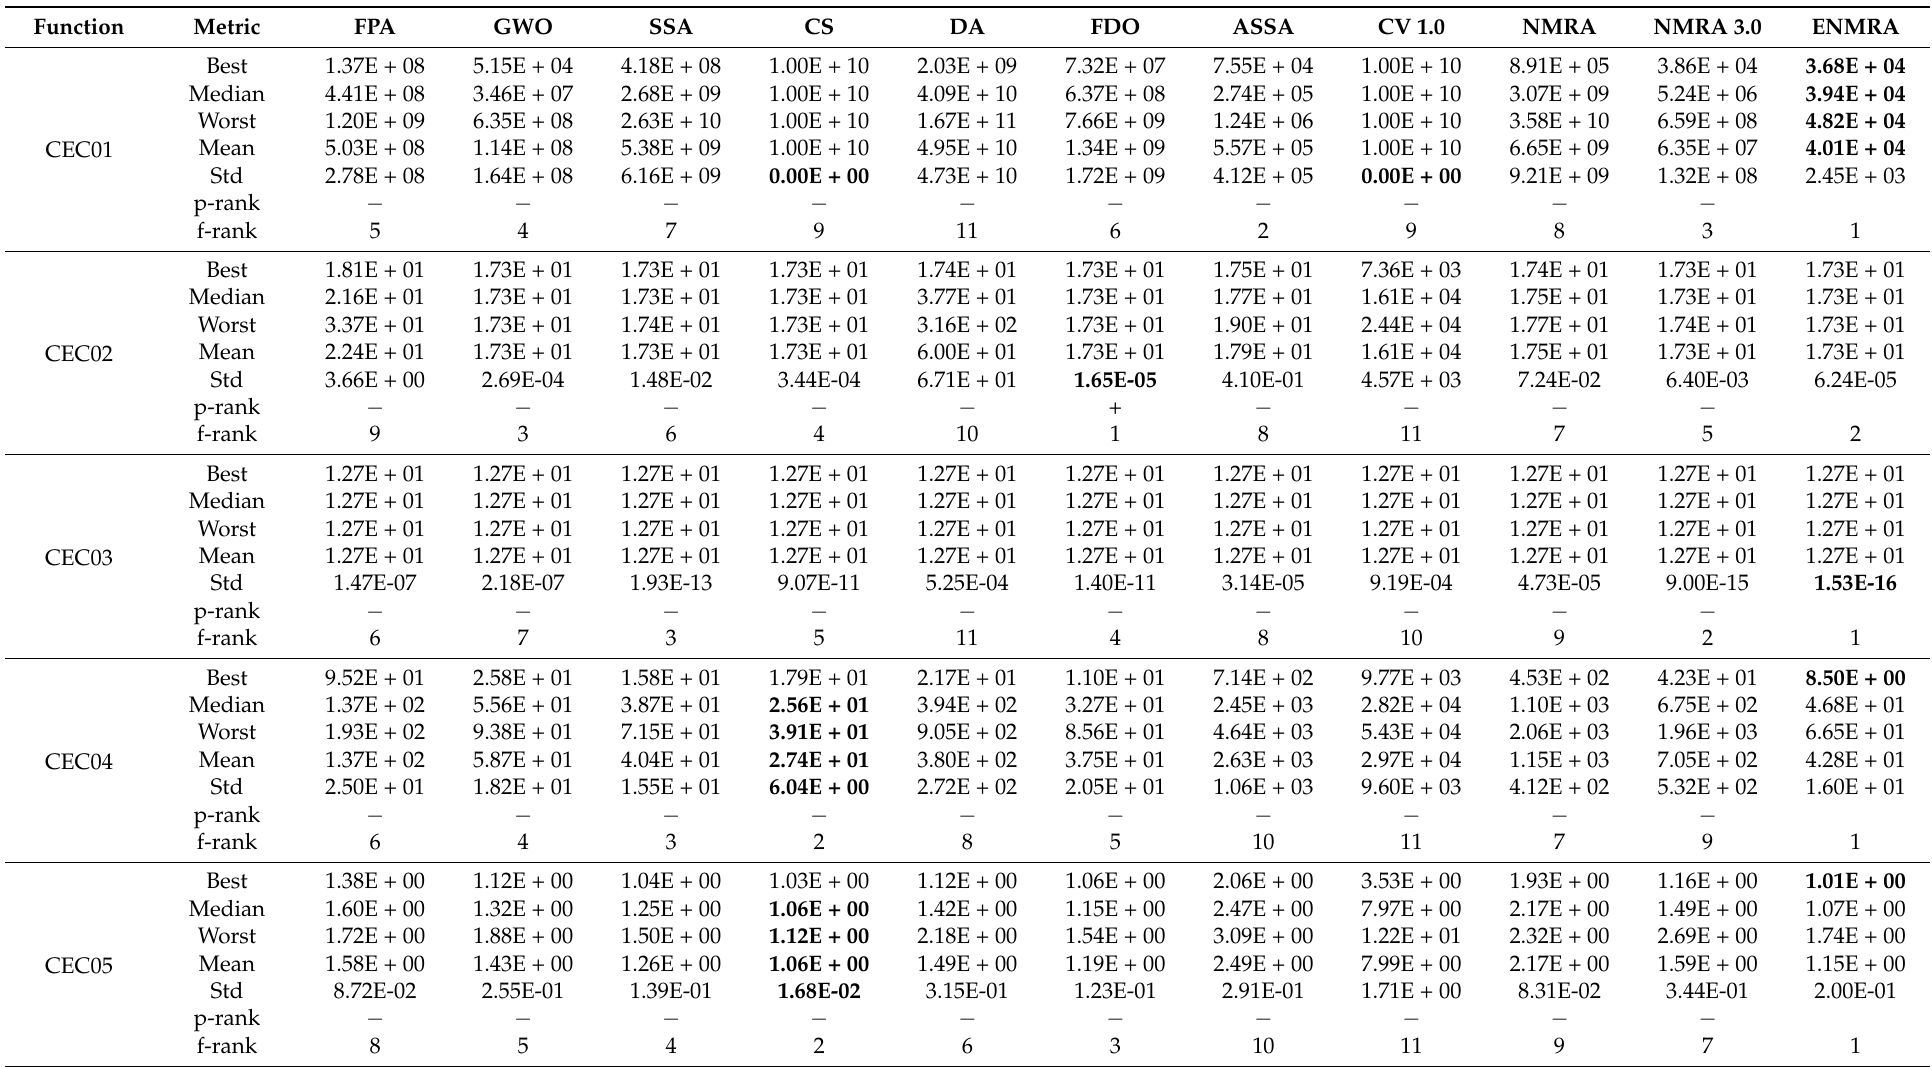
Table 2. Statistical analysis of competitive algorithms for CEC 2019 test